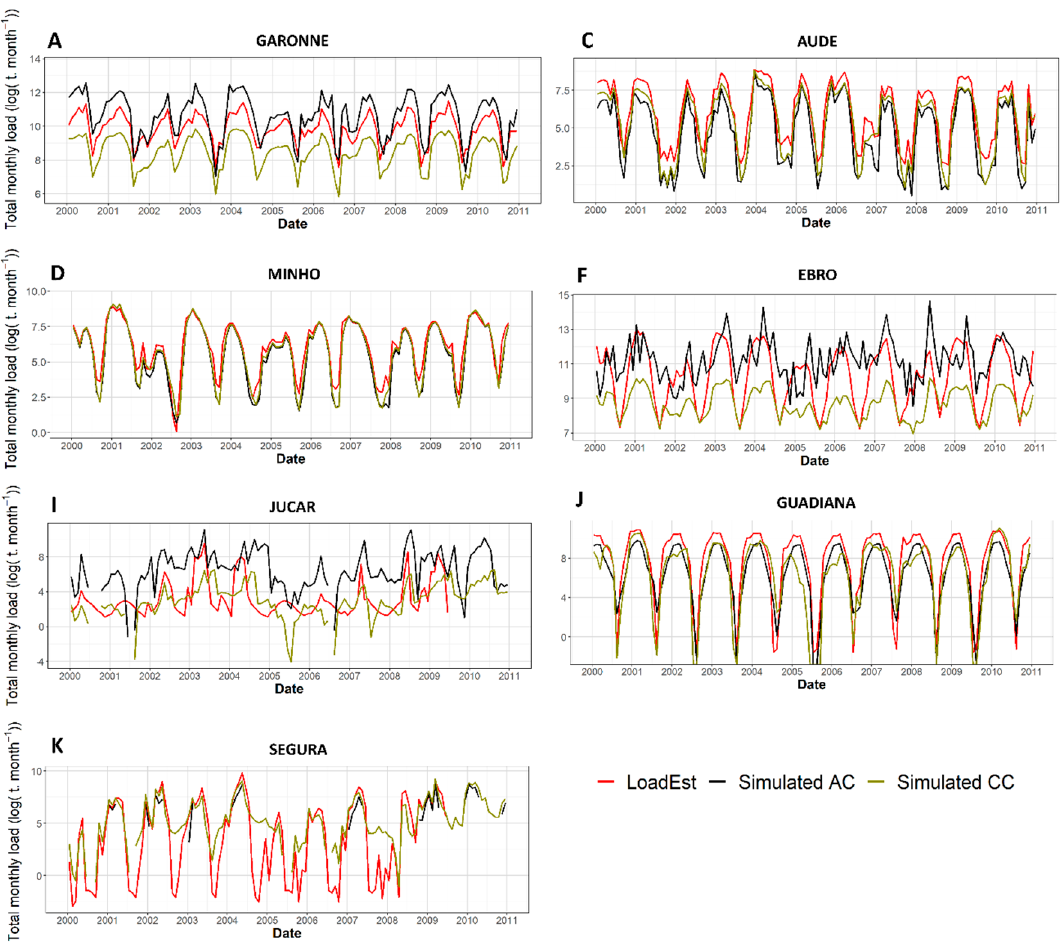
Figure 9. Monthly variation of sediment loads from 2000 to 2010 (calibration period: 2000–2005, validation period: 2006–2010) obtained with LOADEST and SWAT calibrations in the main SUDOE watersheds (AC: additional calibration; CC: conventional calibration). The letters ( A , C , D , F , I – K ) indicate the watershed localization over SUDOE territory (Figure 2).